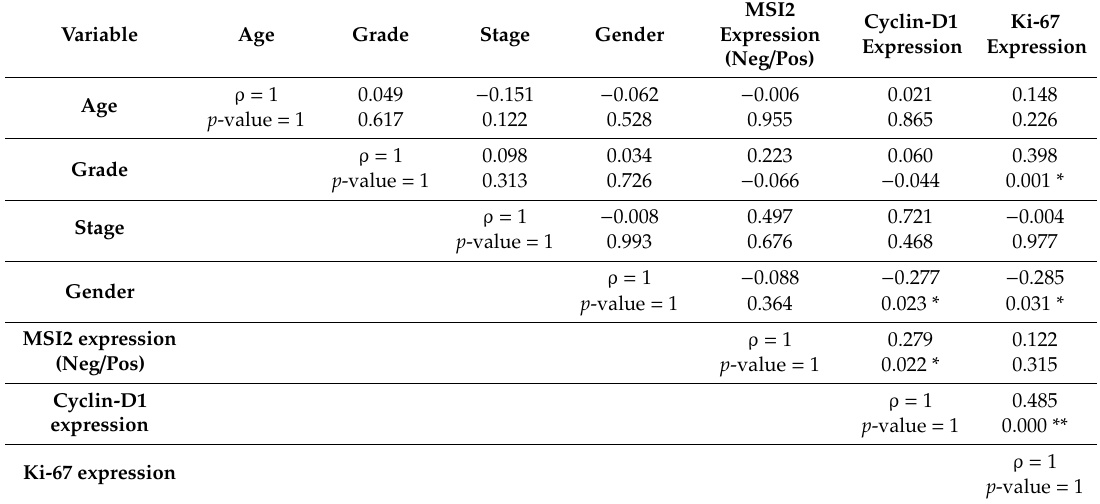
Table 4. Spearman rank correlation for patients included in the TMA. Age. Cyclin-D1 and Ki-67 were included as continuous variables. while Grade. Stage. Gender. and MSI2 as categorical variables.